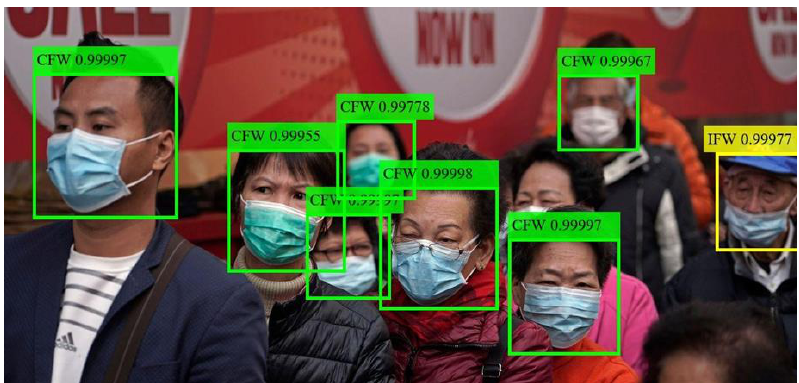
Figure 8. Identification examples in real situations. The labels show the identification results and confidences of SRCNet. CFW = correct facemask-wearing (green), IFW = incorrect facemask-wearing (yellow), NFW = no facemask-wearing (red). The original image was from Medical Masks Dataset (https://www.kaggle.com/vtech6/medical-masks-dataset).